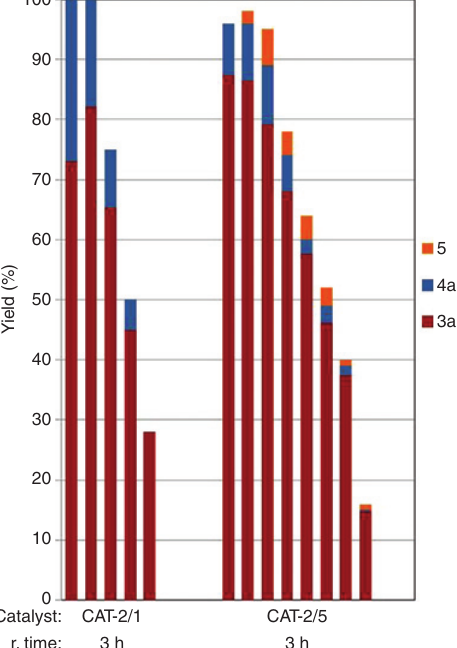
Figure 7: Selectivity and recyclability of catalysts in aminocar- bonylation carried out in DMF at 5 bar [0.2 mmol 1 , 0.5 mmol 2a , 0.25 mmol Et N, catalyst (with 3.6 μ mol Pd-content), 1 ml DMF, 5 bar 3 CO, 100 °